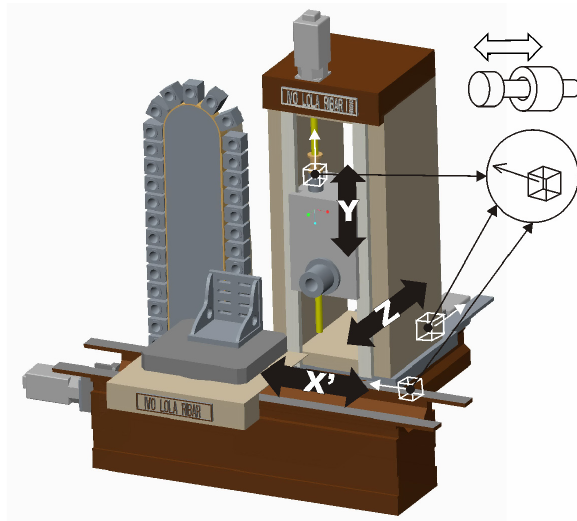
Figure 3. Virtual machine tool LOLA HBG 80 V3 with defined kinematic chain [9]